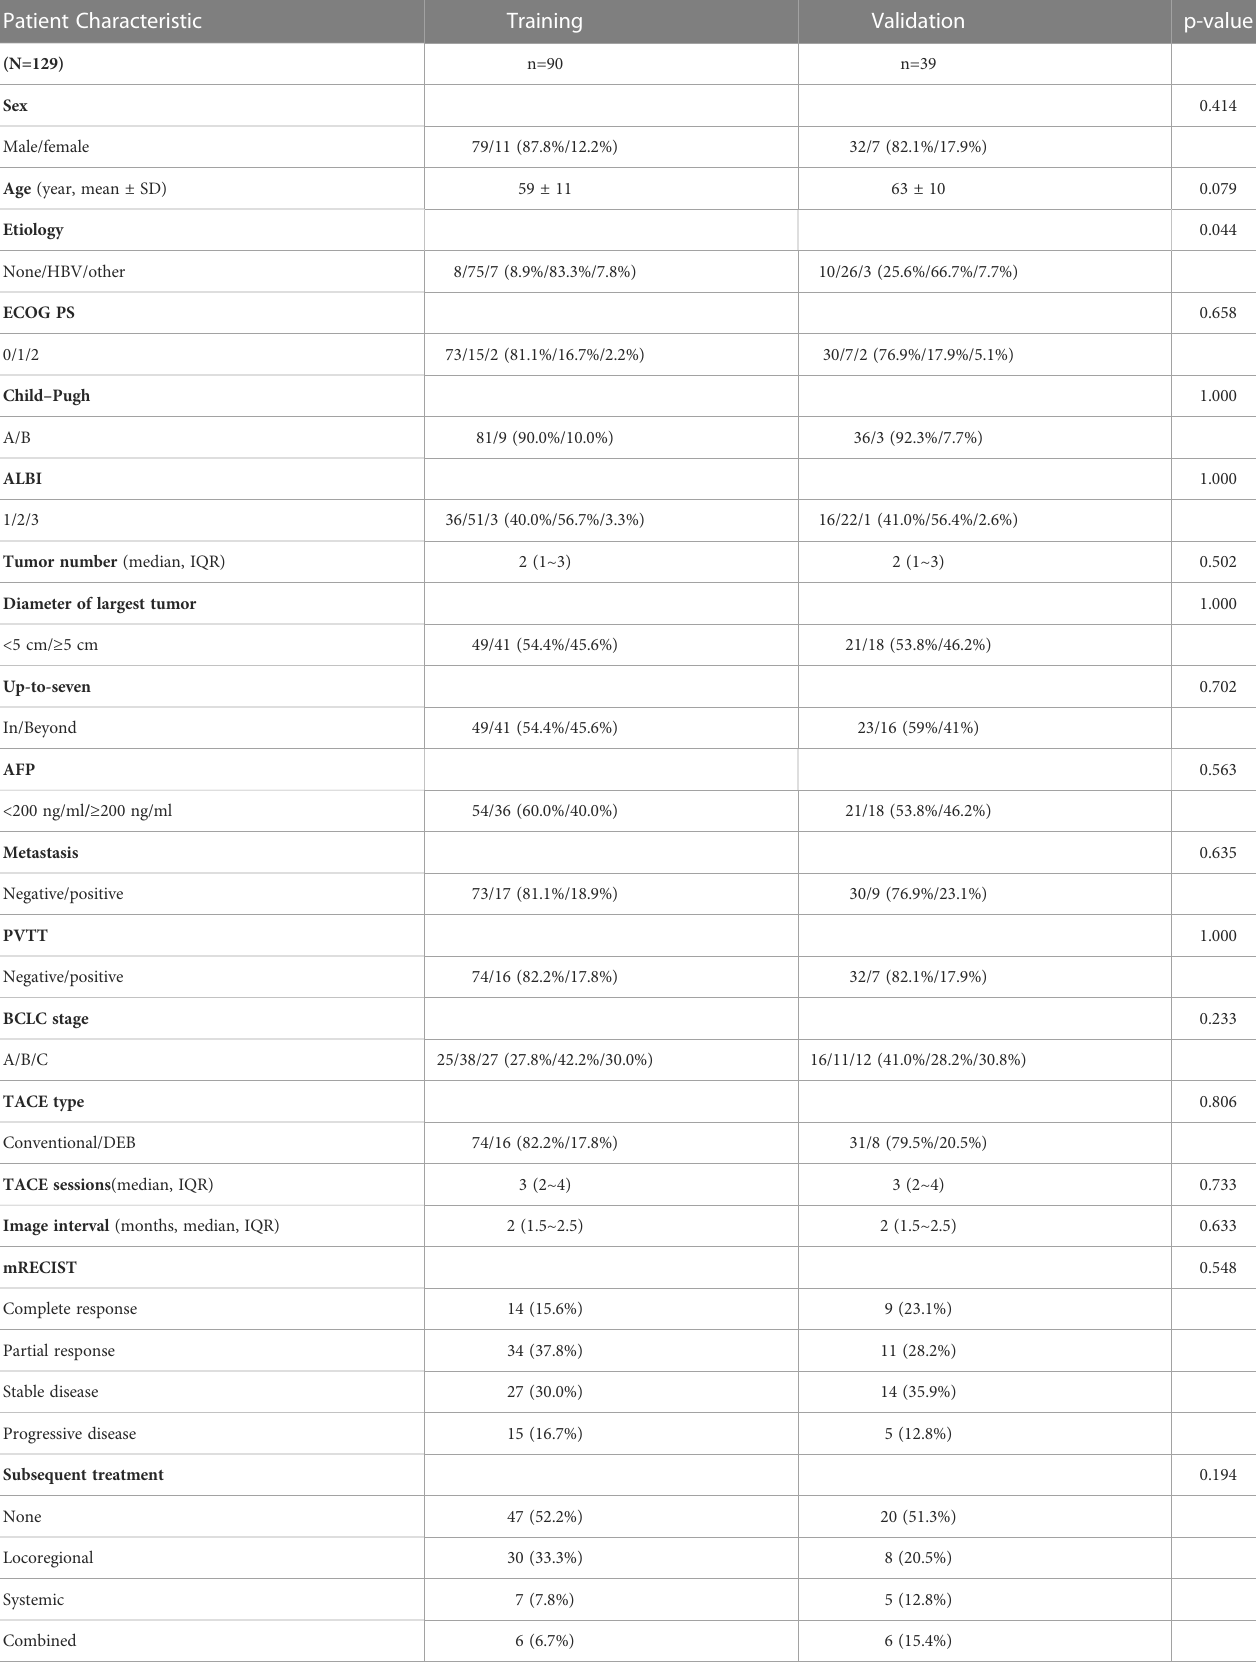
TABLE 1 Baseline patient